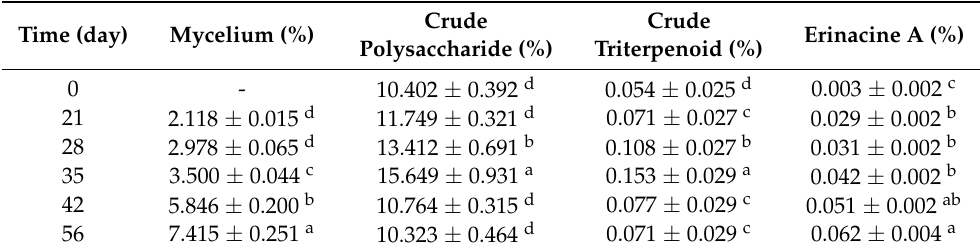
Table 1. Effect of fermentation time on mycelium and bioactive compound contents in Hericium erinaceus solid-state fermented wheat product.